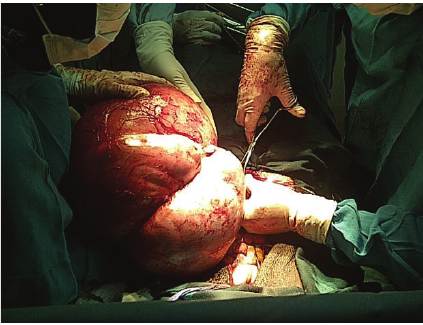
Figure 3: The abdominal and pelvic cavity after excision of the mature ovarian cystic teratoma. Note the normal